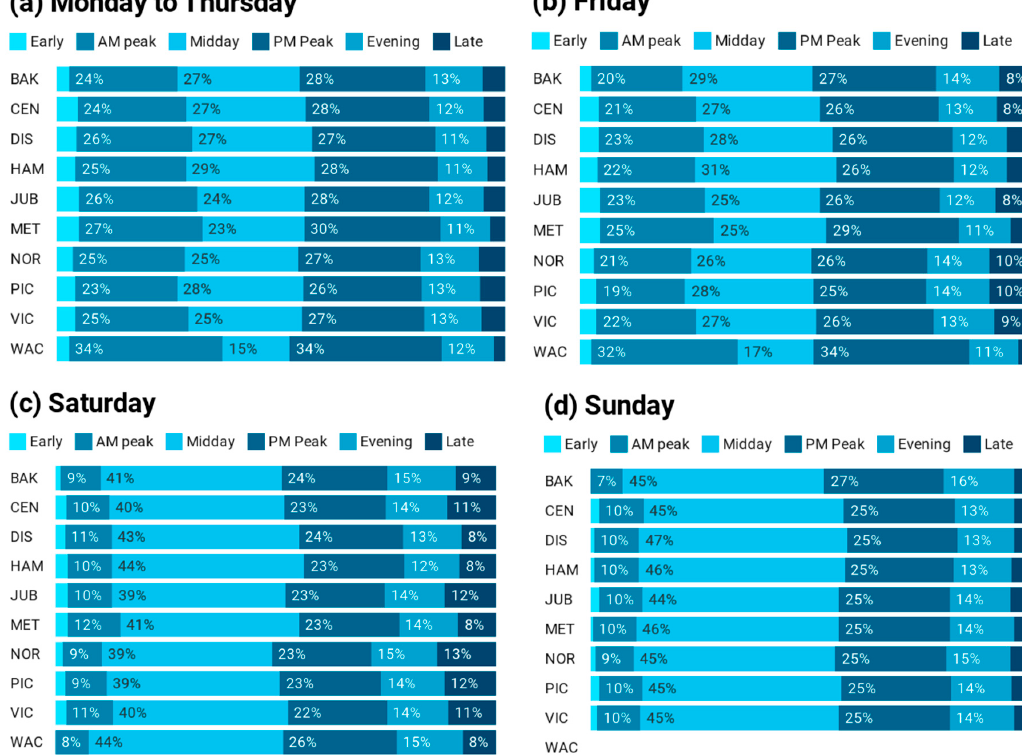
Figure 11. LU passengers per day of week, line, and time band.